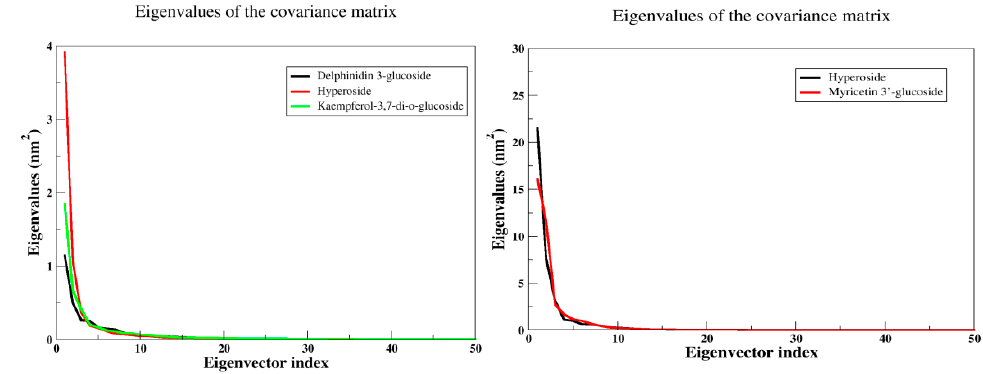
Figure 15. The PCA analysis, the plot of eigenvalues vs. eigenvectors have been considered.